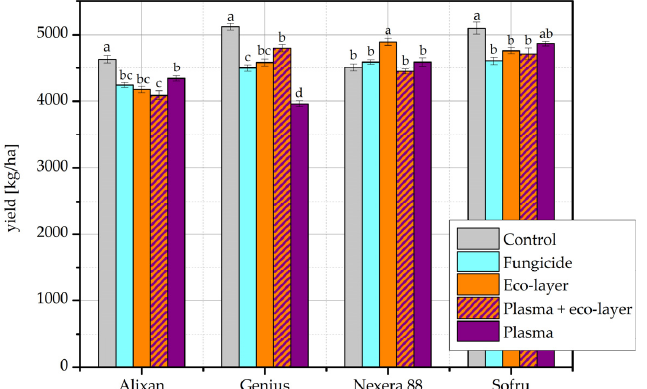
Figure 3. Yield results (kg/ha) of the field experiment according to individual treatments and cultivars of wheat in the year 2019/20. The error bars represent standard error. Different lowercase letters above data points represent statistically significant differences ( p < 0.05; post hoc Tukey’s range test) between treatments.